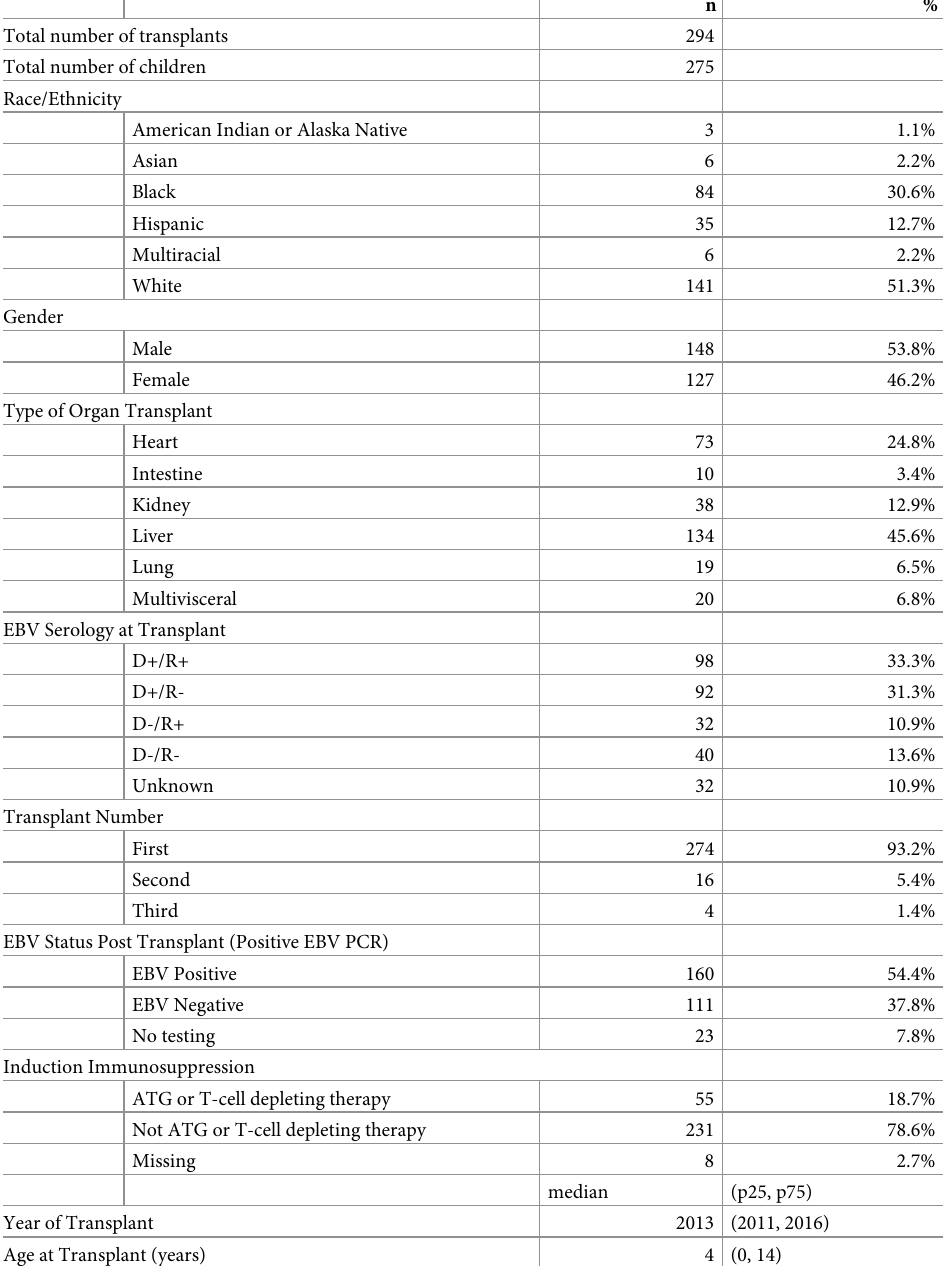
Table 1. Characteristics of all children in the study, regardless of PTLD or EBV